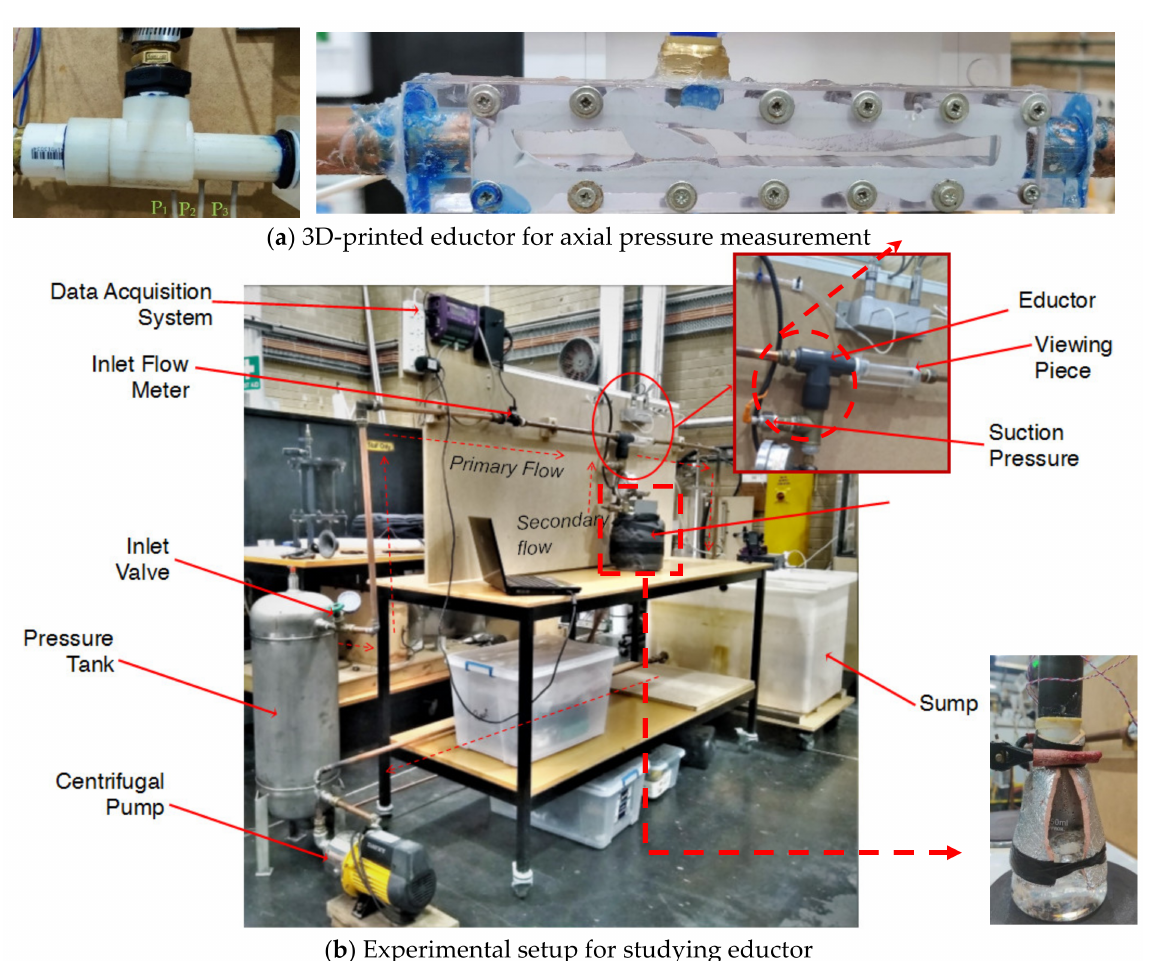
Figure 2. Arrangement for experimental study of